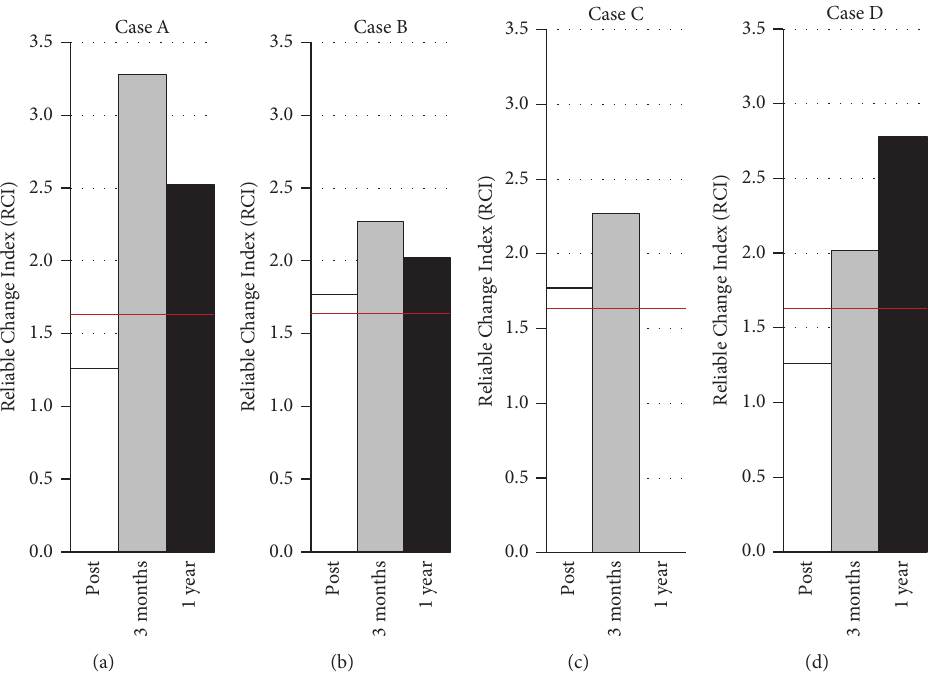
Figure 1: Reliable change indices (RCIs) for theory of mind (ToM) performance on the COST for the four cases. Post = RCI from baseline to posttreatment; 3 months = RCI from baseline to three months after treatment; 1 year = RCI from baseline to 1 year after treatment. The red lines indicate the statistical threshold of